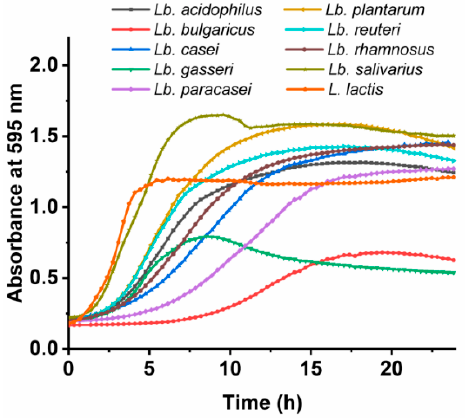
Figure 1. Representative growth curves of the Lactobacillus spp . and L. lactis . Table 3. Growth rates and lag times of the Lactobacillus spp. and L. lactis determined from their growth curves.